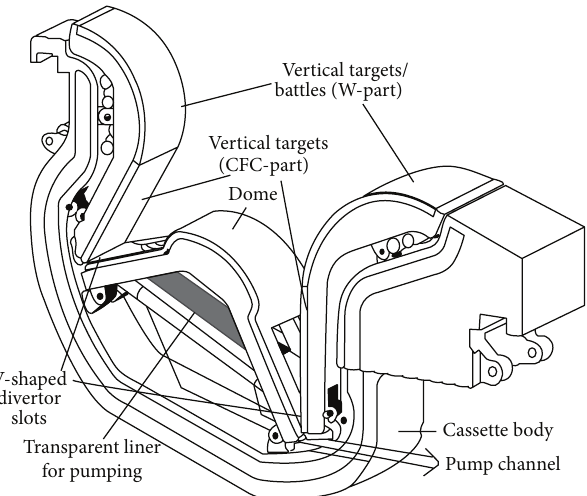
Figure 4: Divertor cassette showing the large openings in the dome support. Also the transparent liner is shown allowing for pumping access from the private flux region [43].